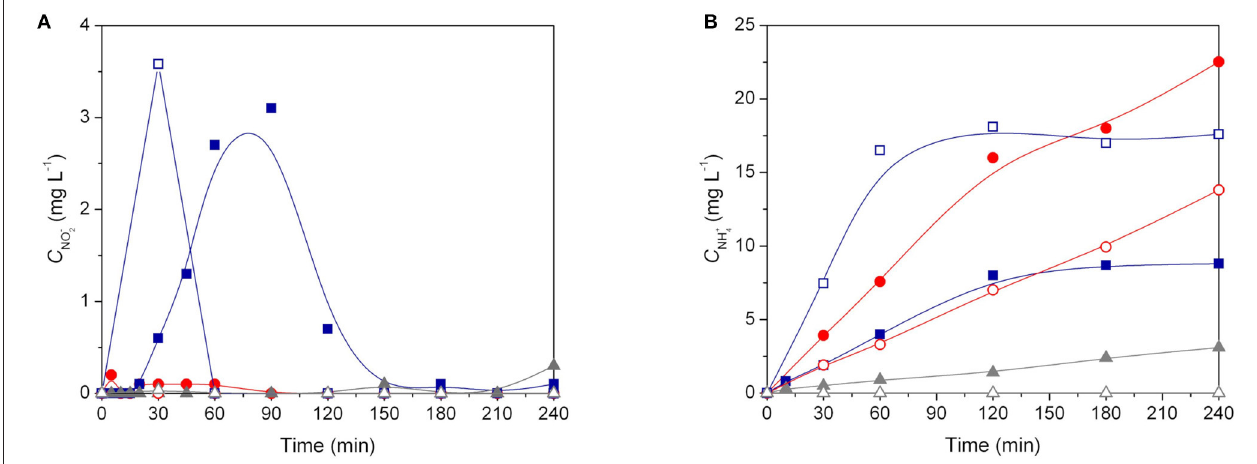
, S N ) using Pd-Cu loaded TiO 2 and CNT-TiO 2 catalysts after , S NH 2 4 + 2 −